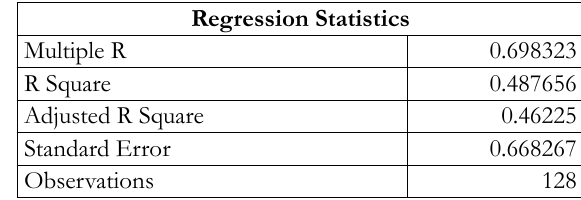
Table 16. Regression statistics of Support services against increased usage of ICTs ANOVA df SS MS